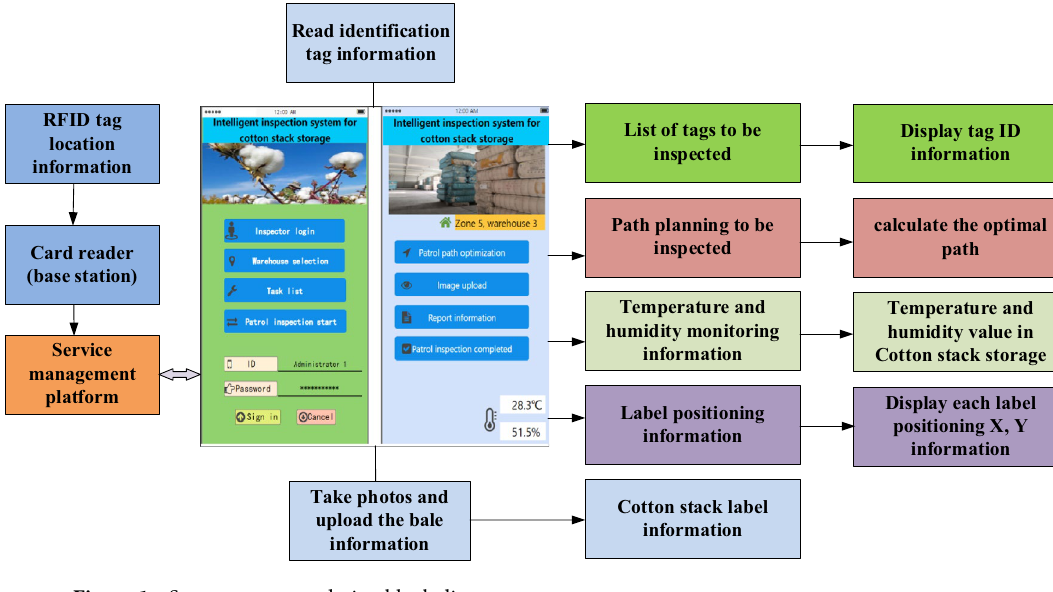
Figure 1. System structure design block